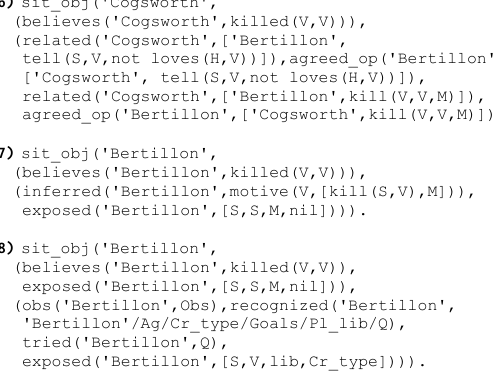
Fig. 1. Flow of control of PlotBoard